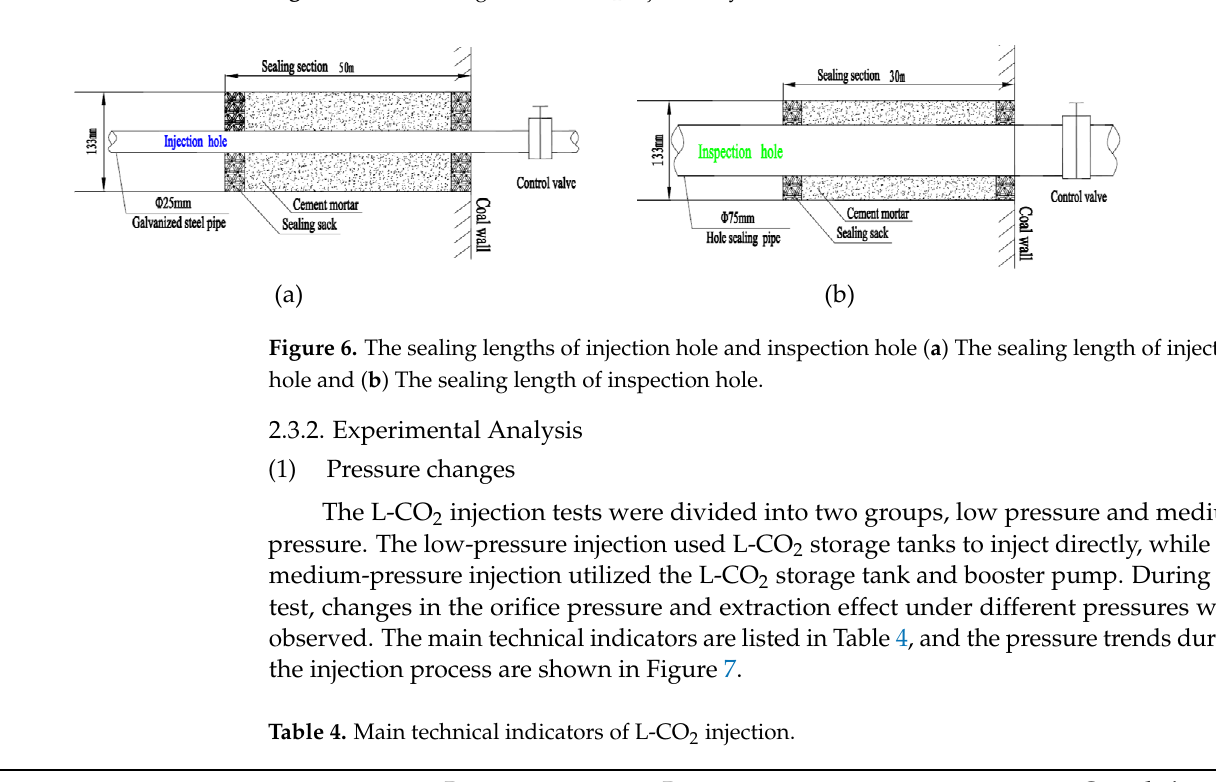
Table 4. Main technical indicators of L-CO 2